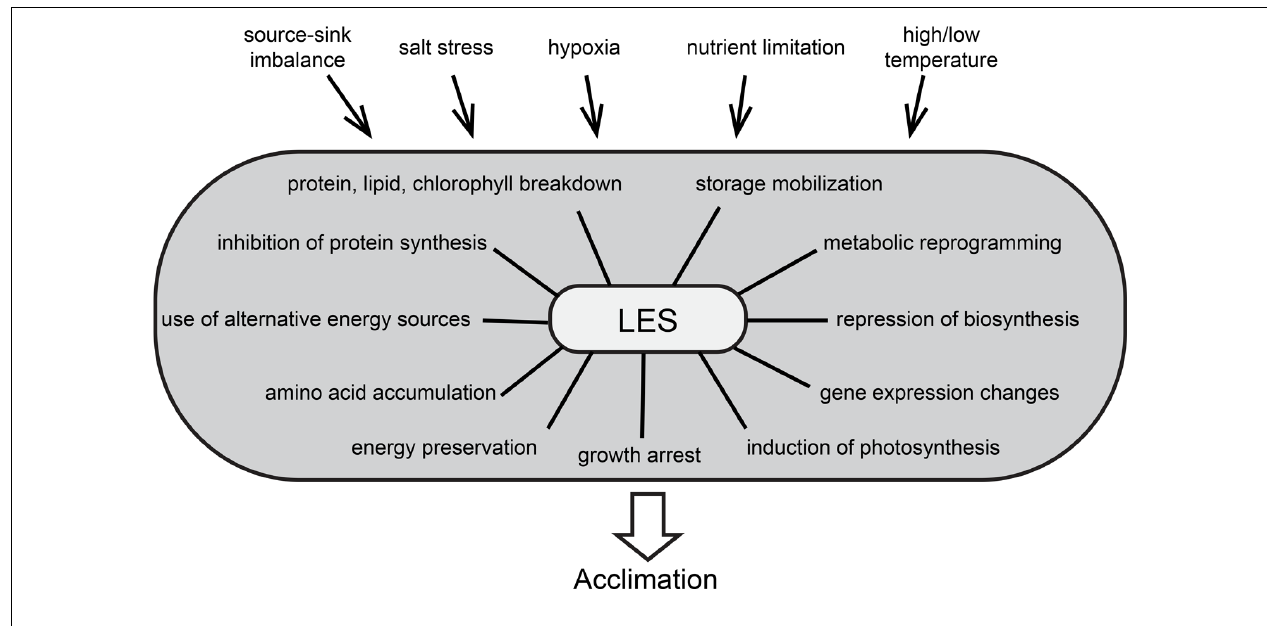
FIGURE 1 |The low energy syndrome (LES) is a collection of phenotypical consequences of stress condition and drives plant acclimation to environmental changes. The figure aims at depicting all